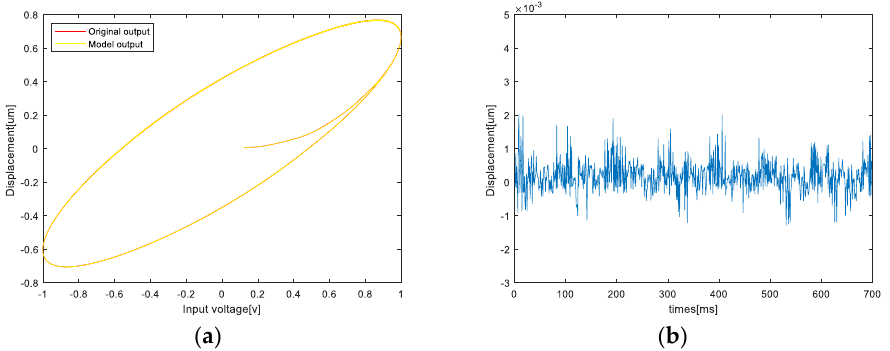
Figure 9. When the input frequency f = 100 Hz: ( a ) hysteresis model; ( b ) modeling error.